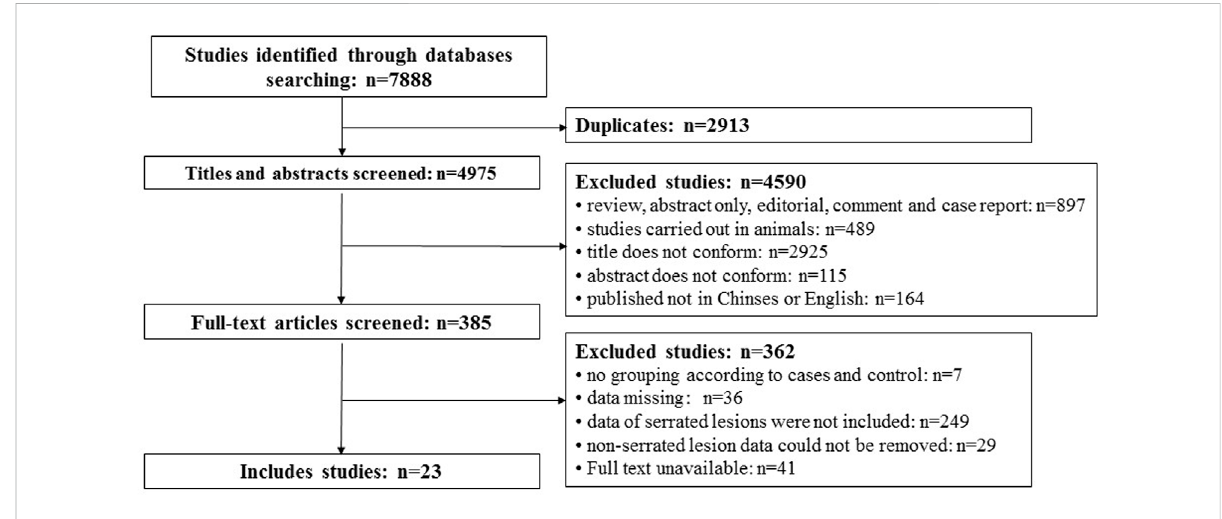
FIGURE 1 Flow diagram of literature include and